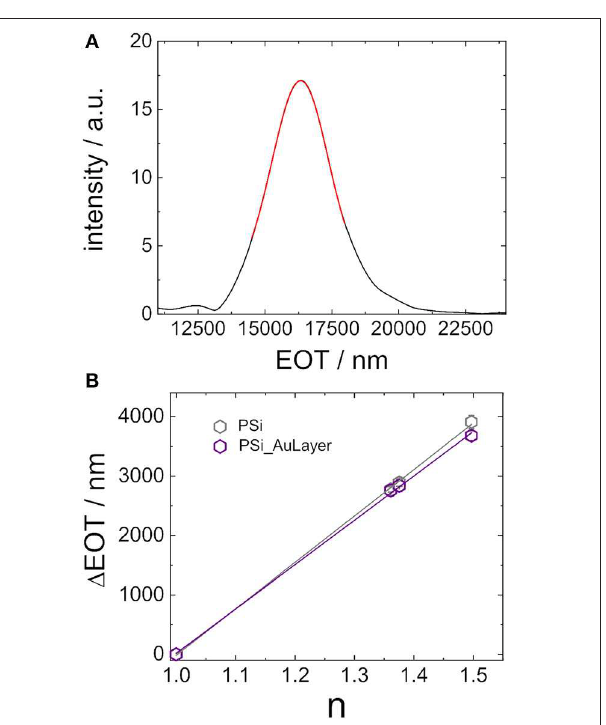
Hence, the sensitivity of an interferometric sensor might